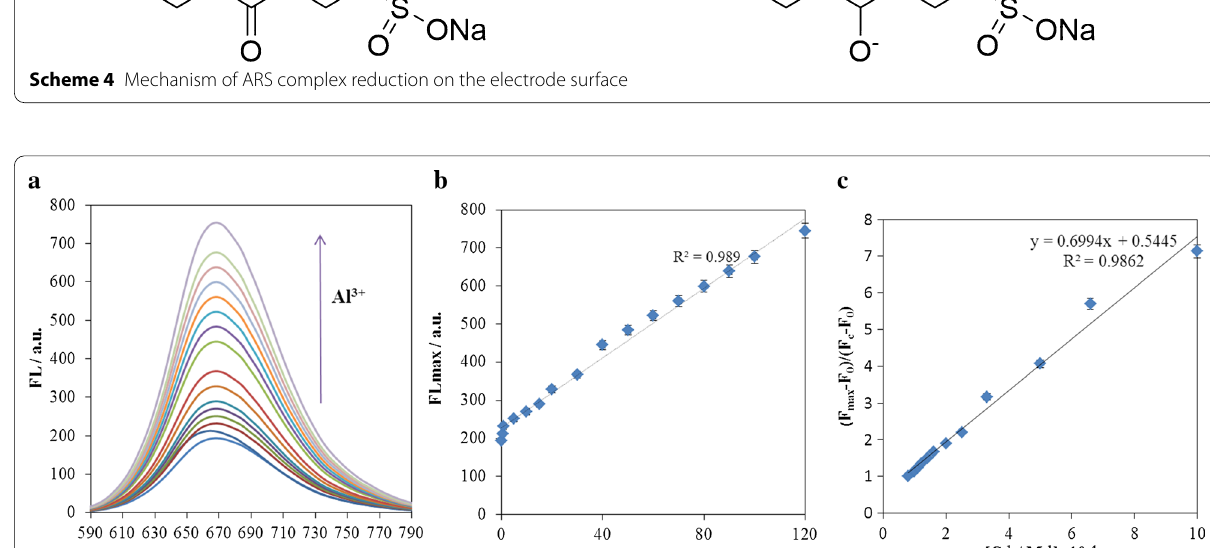
Fig. 10 a , b The changes of fluorescence intensity ( λ exc. 388 nm) of ARLD-5 electrode after adding different concentrations of Al 3 + [Al 3 + = concentration range 0.2–120 μM], c the fluorescence intensity changes in terms of Al 3 + concentration